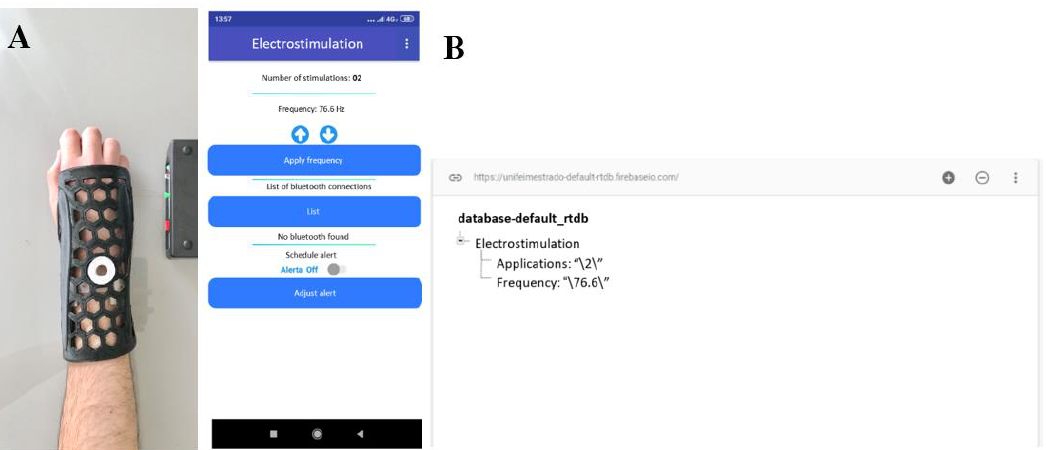
Figure 5. Representation of the system as a whole, ( A ) orthosis integrated with the stimulator controlled by the app; ( B ) mobile app interface with database records highlighting the number of electrostimulation applications and magnetic field frequency.